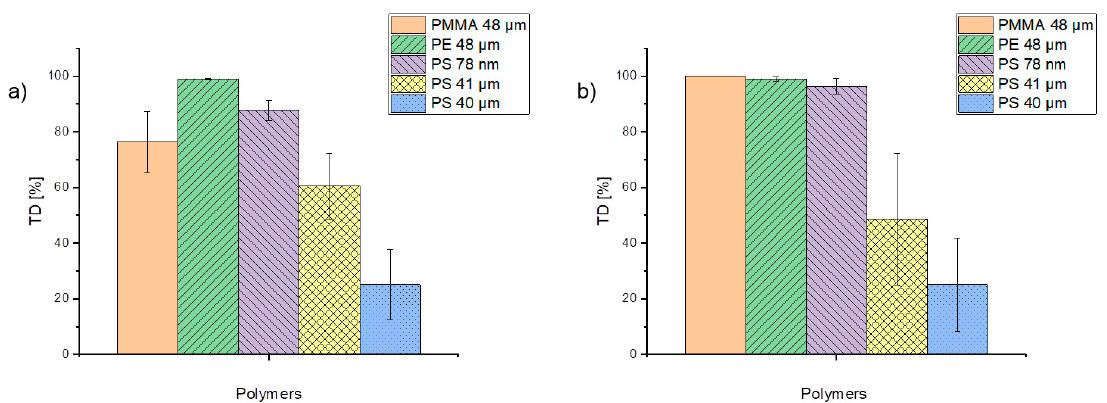
Figure 7. Percentage of phenanthrene in the concentrations of 1 µg/mL ( a ) and 0.1 µg/mL ( b ) desorbed during TD from the particles.